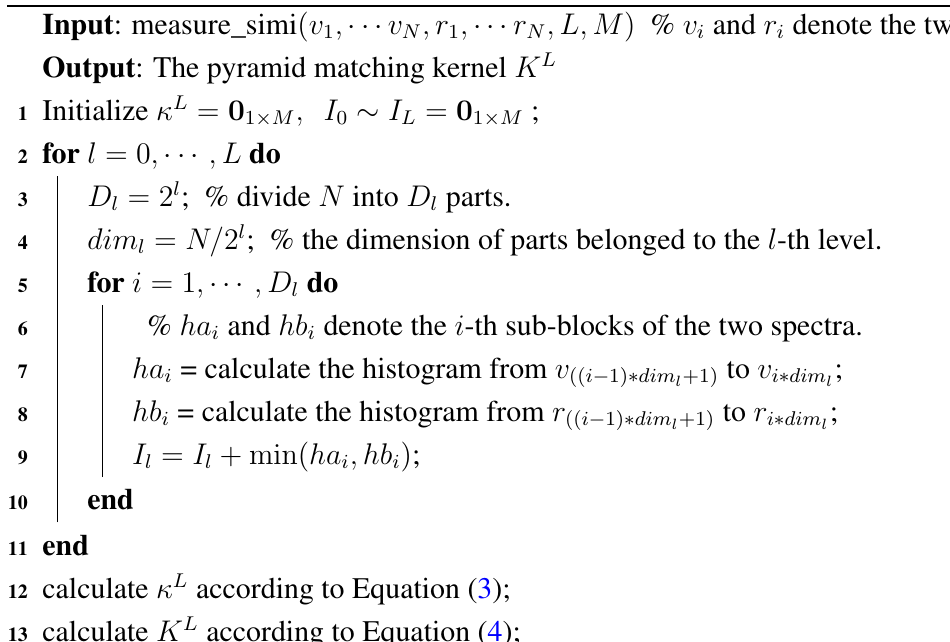
Algorithm 1: The similarity measure via spatial pyramid matching